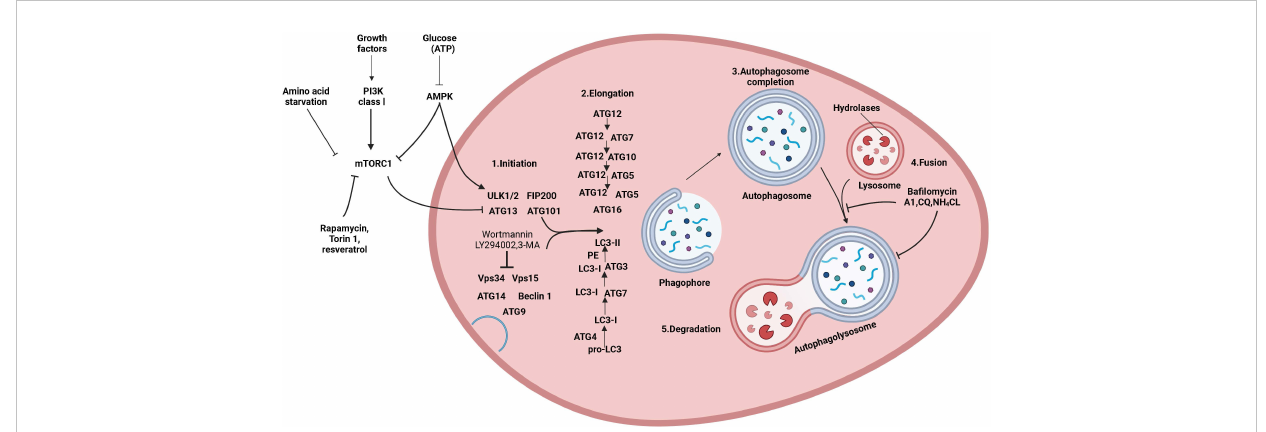
FIGURE 1 The mechanism of autophagy and its regulation. Molecular circuits and signaling pathways that regulate autophagy. Autophagy is a complex self-degradation process involving the following key steps: the control of Beclin-1/VPS34-mediated formation of phagosomes on the ER and other membranes in response to stress signaling pathways; Atg5-Atg12 conjugation and interaction with Atg16L and the multimerization of the phagosome; LC3 processing and insertion into the extended phagosome membrane; the capture of random or selective targets for degradation to complete the autophagosome while ATG4 recycles some LC3-II/ATG8; and autophagosome fusion with lysosomes and proteolytic degradation of the engulfed molecules by lysosomal proteases. Autophagy is regulated by important signaling pathways in cells, including stress signaling kinases such as JNK-1, which promotes autophagy by phosphorylating Bcl-2, thereby promoting the interaction of Beclin-1 with VPS34. Perhaps the core signaling molecule that determines the level of autophagy in cells is the kinase mTOR, which can mediate its effect on autophagy by inhibiting the ATG1/Ulk-1/-2 complex in the earliest stage of lipid bilayer phagophore